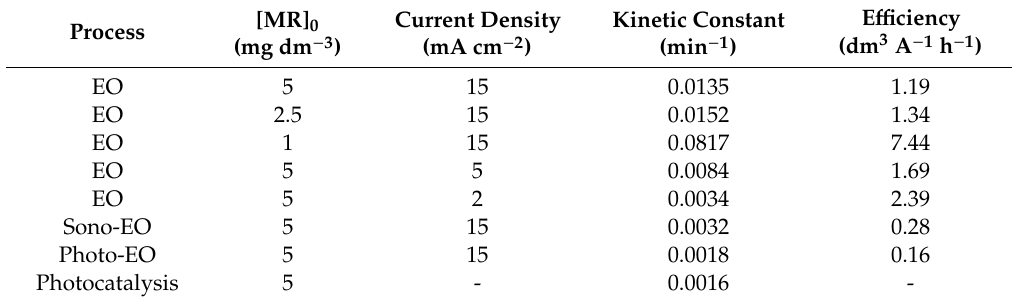
Table 1. Kinetic constant and e ffi ciency calculated for the di ff erent experiments